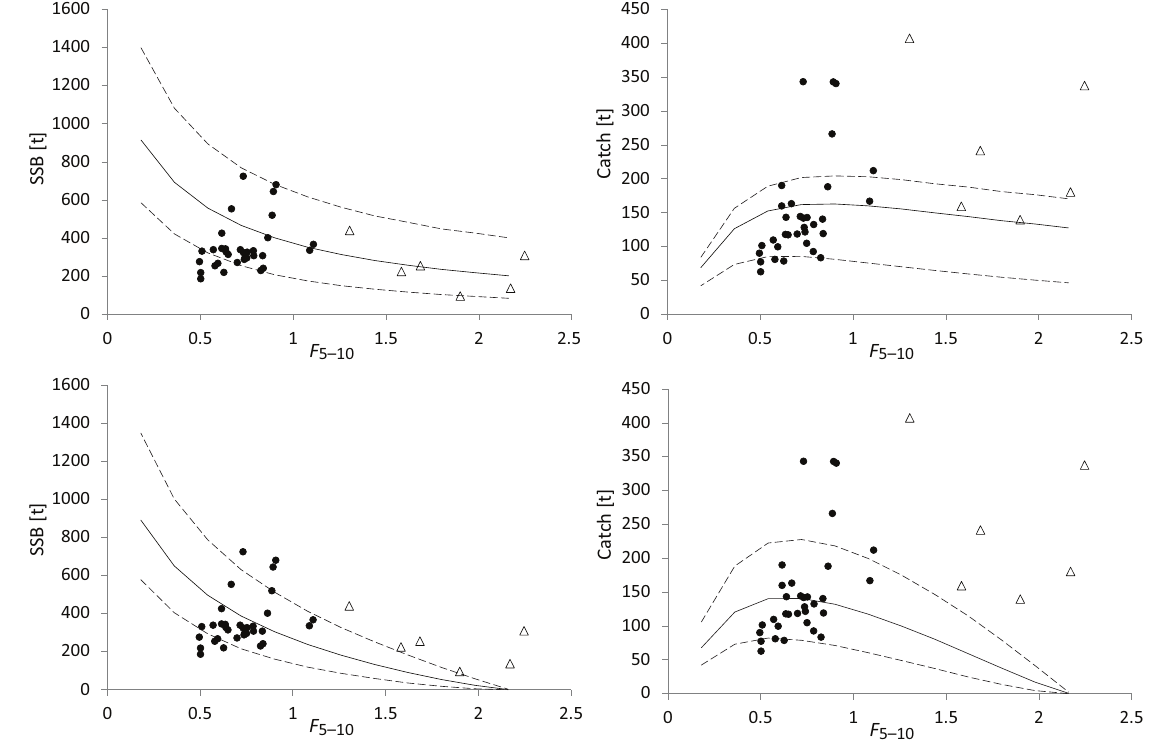
Fig. 3. Spawning stock biomass (left) and catch (right) in equilibrium with different levels of fishing mortality, assum- ing no (top) or significant catch (bottom) of immature, undersized pikepearch ( Sander lucioperca ); Lines show average simulated SSB and catch (continuous), with 5% and 95% percentiles (dashed); Markers denote observed SSB and catches (Eero 2004) with no (circles) or significant (triangles) catch of immature fish; F 5–10 = average